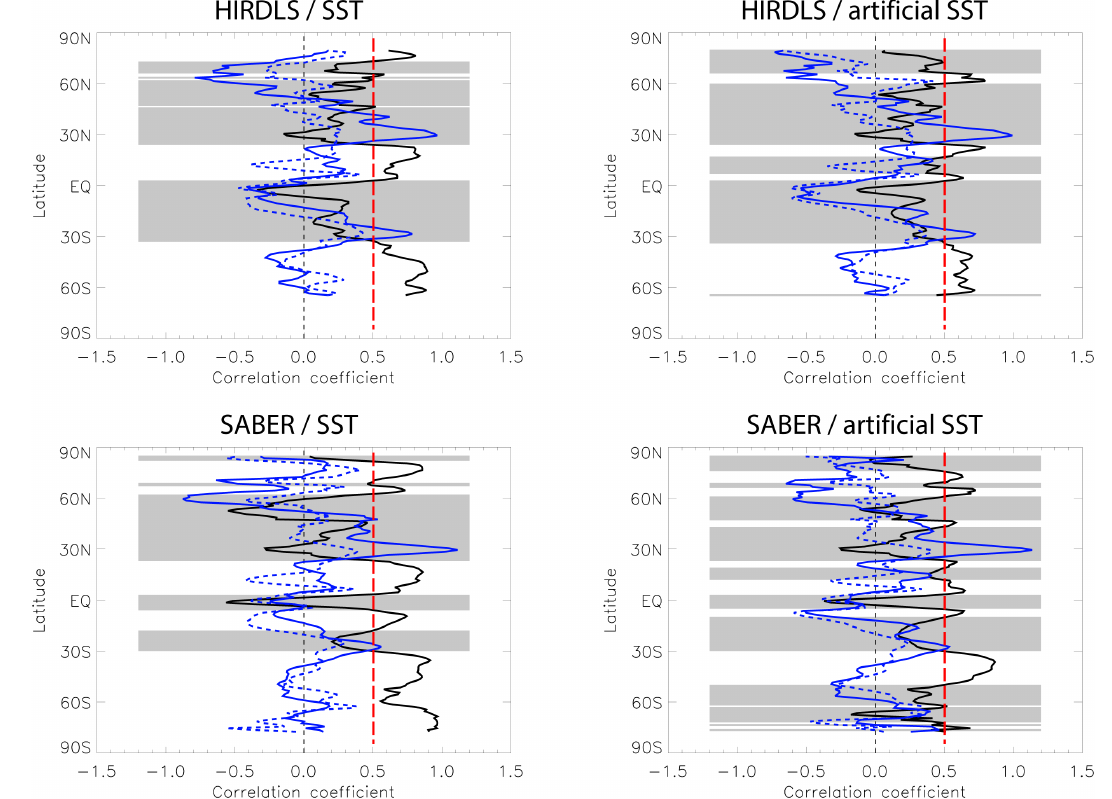
Figure 3. Latitude cross sections of the spatial correlation along one latitude circle between temporal correlations (black) of both observed GWMF and GWMF simulated by GROGRAT with SST, precipitation and temporal correlations (blue dashed) of observed GWMF with SST and the latter but corrected for the correlation between precipitation and the temporal correlation of GWMF simulated by GROGRAT with SST (blue). The gray shading indicates where the correlation between observed and simulated GWMF (i.e., the black line) is below a threshold of